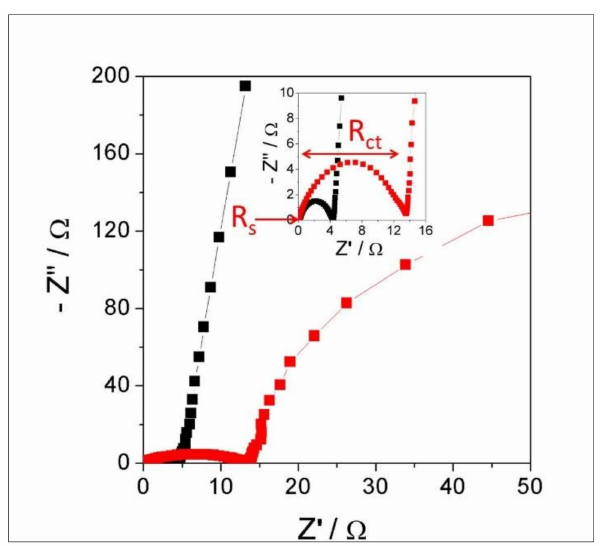
Figure 11. Nyquist diagram, obtained from the EIS experiment performed in acidic (black squares) and basic electrolytes (red squares). The inset shows the magnification of the diagram at the high-frequency range and indicates the R s and R ct of the cell using the basic